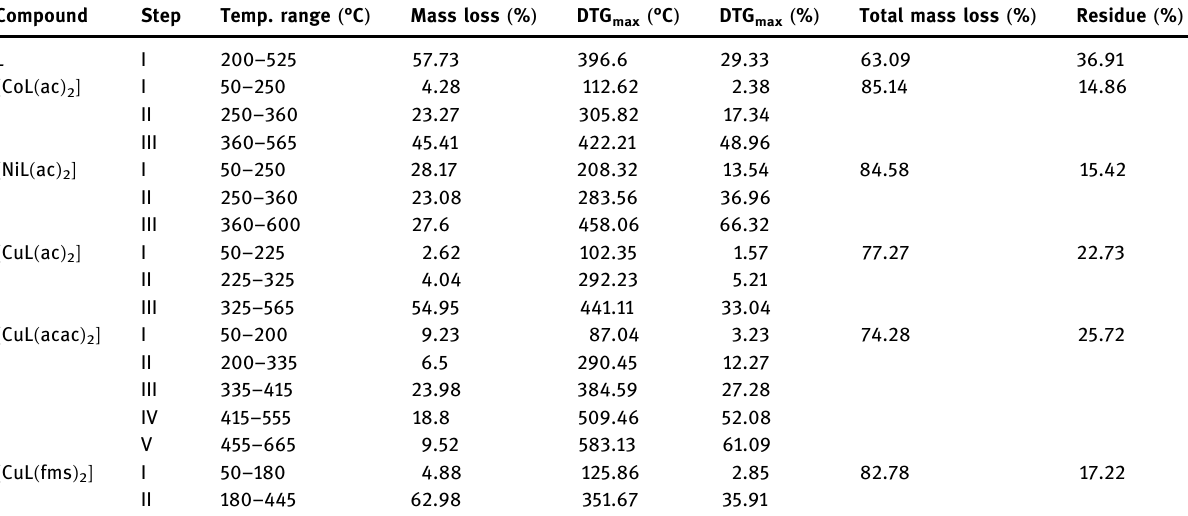
Table 4: Thermoanalytical ( TG - DTG ) data of the ligand and its metal complexes Compound